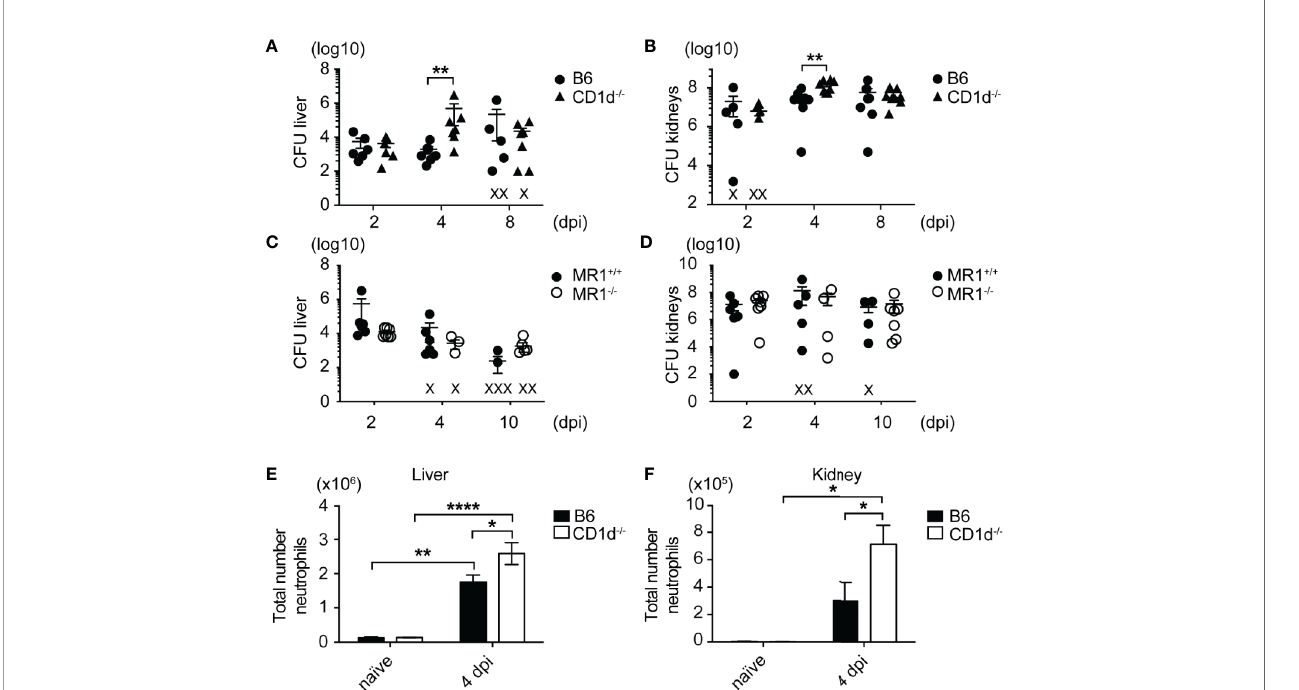
FIGURE 1 | Mice lacking NKT cells have increased bacterial burdens and neutrophilic in fi ltrate in SA infected organs. (A, B) Colony forming units (CFU) quanti fi ed in liver (A) and kidneys (B) of B6 and CD1d -/- mice at various times post infection (N=6 – 8 mice/genotype/timepoint). (C, D) CFU quanti fi ed in liver (C) and kidneys (D) of MR1 +/+ and MR1 -/- mice at various times post infection (N=4-7 mice/genotype/timepoint). (E, F) Total number of neutrophils in the liver (E) and kidney (F) of infected mice (liver: N=3 naïve, N=14 4 dpi/genotype, kidney: N=4 naïve, N=11-12 4 dpi/genotype). Statistical analysis: (A – D) Mann-Whitney test; (E, F) 2-way